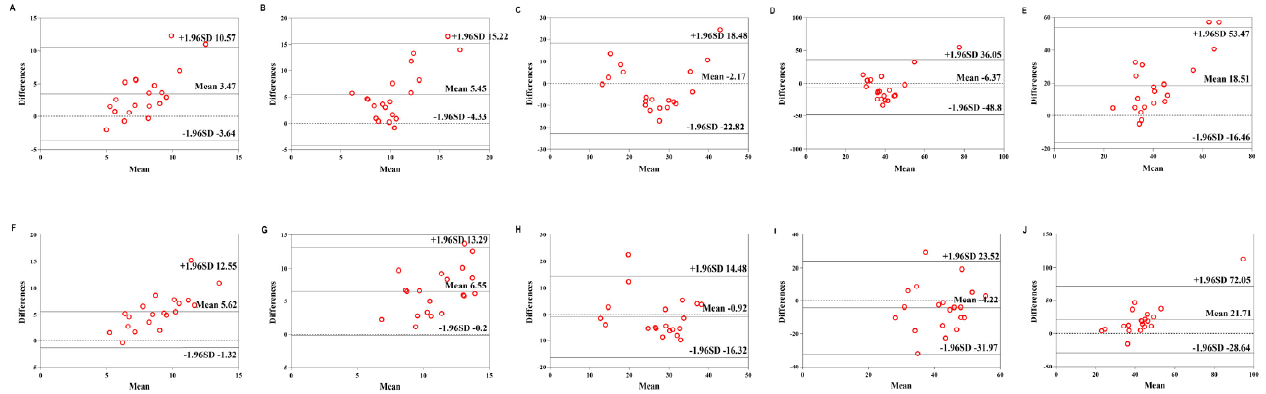
Figure 8. Comparison between the Lexin Mio smart bracelet (Mio) and gas-analysis system (GAS) for energy expenditure (EE) in the high-physical-activity level (HPAL) group. ( A ) Bland–Altman plots of mean of left Mio and GAS for EE under rest condition. ( B ) Bland–Altman plots of mean of left Mio and GAS for EE under the low-intensity exercise. ( C ) Bland–Altman plots of mean of left Mio and GAS for EE under the middle-intensity exercise. ( D ) Bland–Altman plots of mean of left Mio and GAS for EE under the high-intensity exercise. ( E ) Bland–Altman plots of mean of left Mio and GAS for EE under recovery condition. ( F ) Bland–Altman plots of mean of right Mio and GAS for EE under rest condition. ( G ) Bland–Altman plots of mean of right Mio and GAS for EE under the low-intensity exercise. ( H ) Bland–Altman plots of mean of right Mio and GAS for EE under the middle-intensity exercise. ( I ) Bland–Altman plots of mean of right Mio and GAS for EE under the high-intensity exercise. ( J ) Bland–Altman plots of mean of right Mio and GAS for EE under recovery condition.